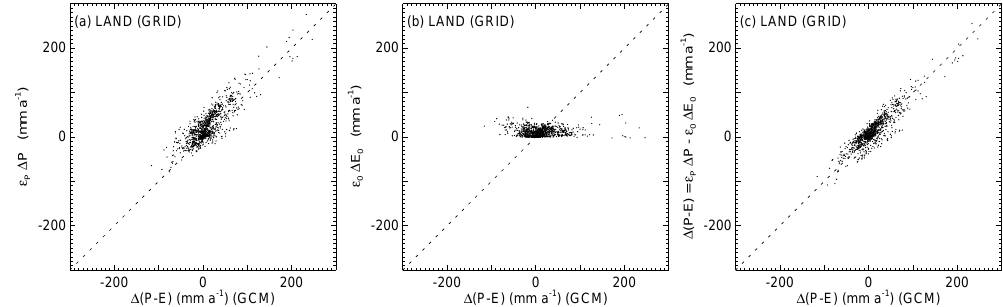
Fig. 4. Comparison between components of the change predicted by the theory with changes projected by the global climate multi-model en- semble mean (GCM). Change in P − E due to change in (a) the rainfall ( ε P 1P) (regression: y =0.89 x + 13.8, R 2 =0.72, N =1119), (b) the evaporative term ( ε o 1E o ) (regression: y =0.01 x + 9.8, R 2 =0.00, N =1119) and the (c) total calculated change ( 1 ( P − E )